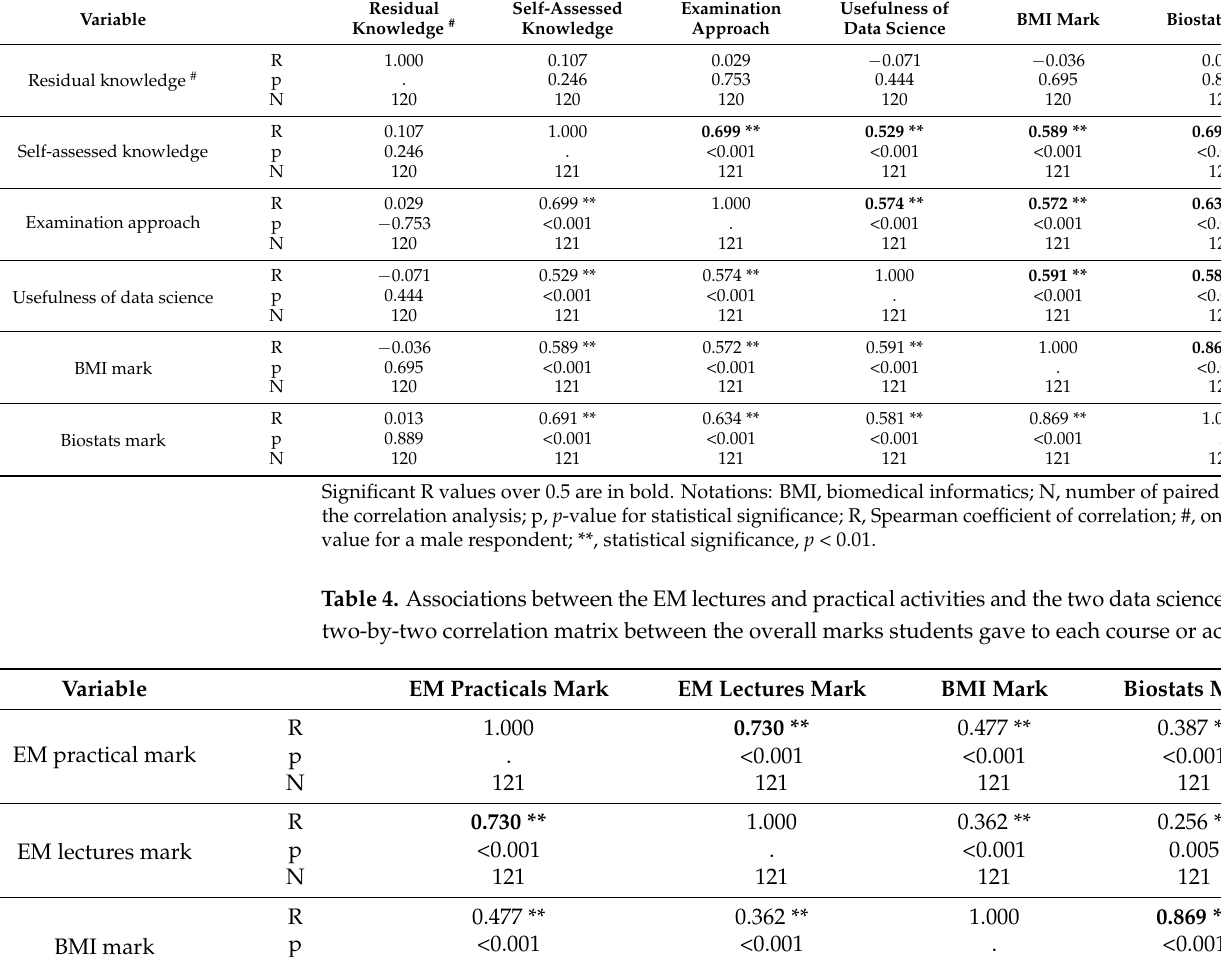
Table 3. Associations concerning the BMI and biostatistics courses: two-by-two correlation matrix between the measured residual knowledge, self-assessed level of knowledge, opinions of the examination approach and usefulness of previous courses and overall marks students gave to each course.